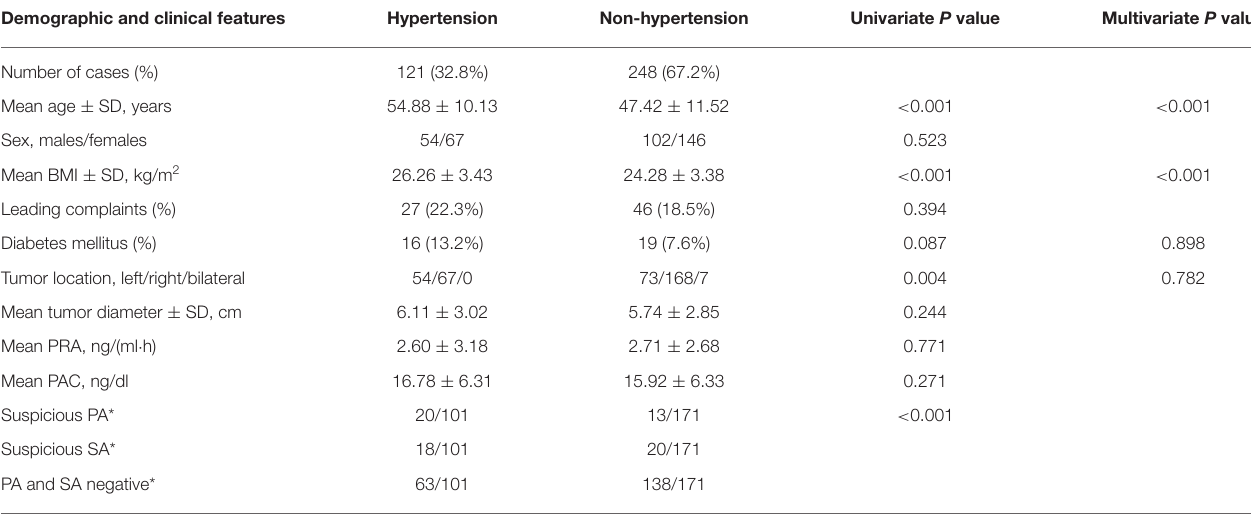
TABLE 1 | Characteristics of patients with AML having hypertension. Demographic and clinical